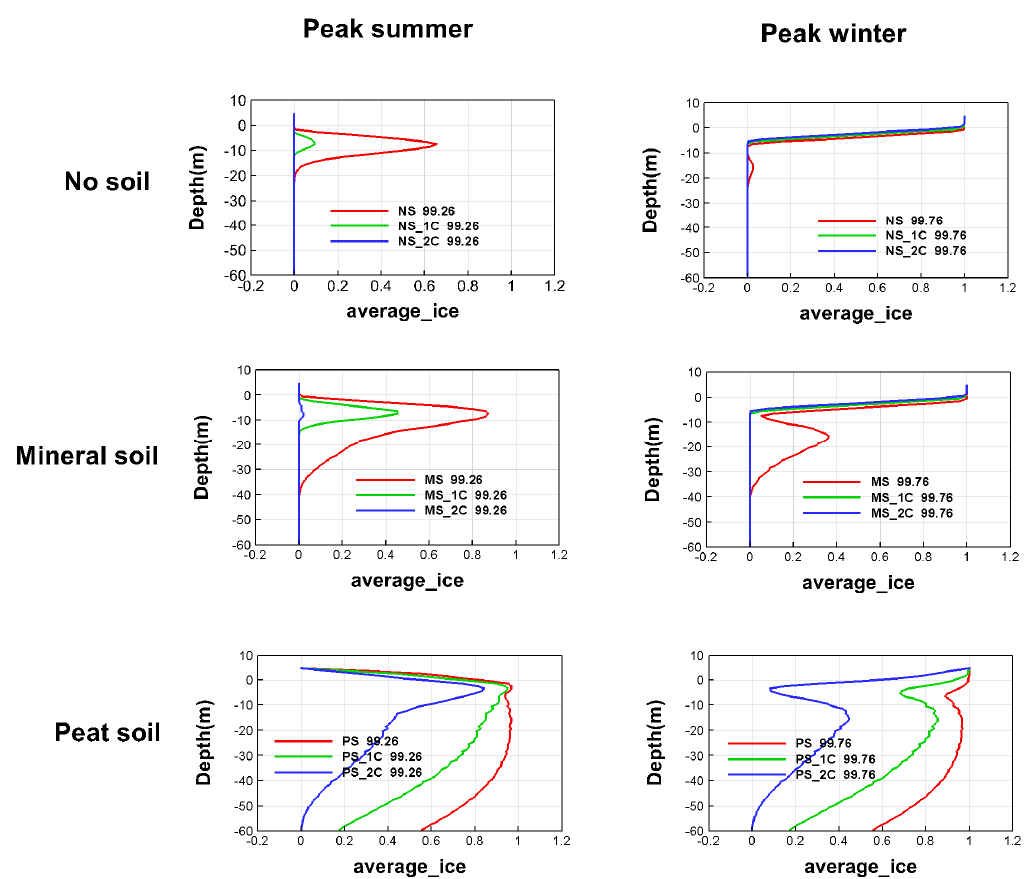
Figure 5. Lateral average ice content after 0, 1, and 2 °C surface warming over 100 years for the simulation cases of no soil (NS), mineral soil (MS), and peat soil (PS) in peak summer ( left ) and peak winter ( right ).